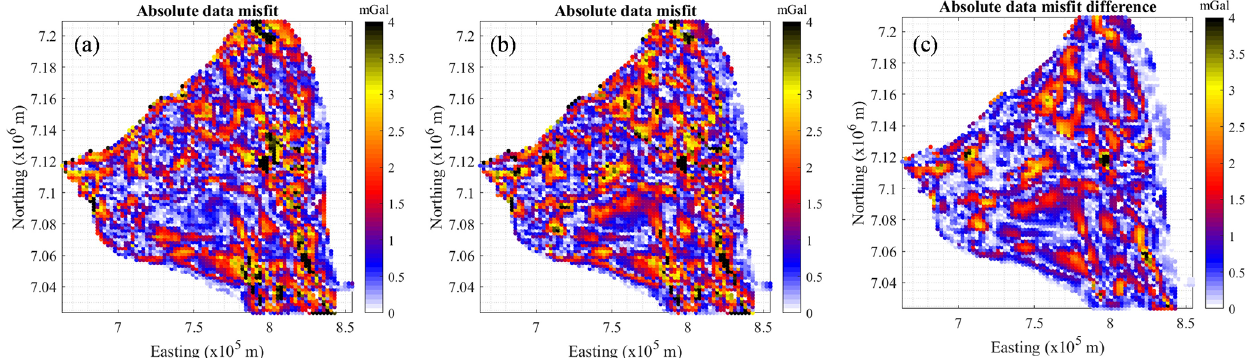
Figure A1. (a) Comparison of absolute data misfit maps obtained for the inverse model used here (reproduced from Giraud et al., 2019a) and (b) after post-regularization, with (c) the misfit differ- ences between panels (a) and (b) .